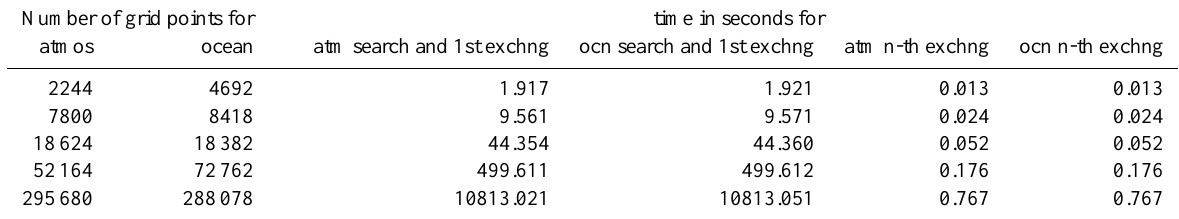
Table 5. As in Table 4 but for OASIS3 with its classical neighborhood search. Number of grid points for time in seconds